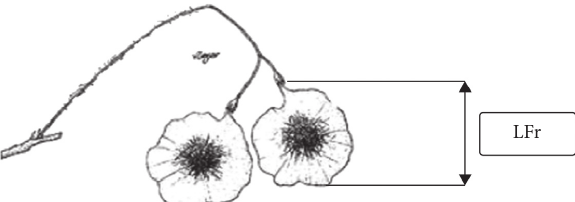
Figure 5: Measurement of the length of fruit (LFr) of P. erinaceus [18].